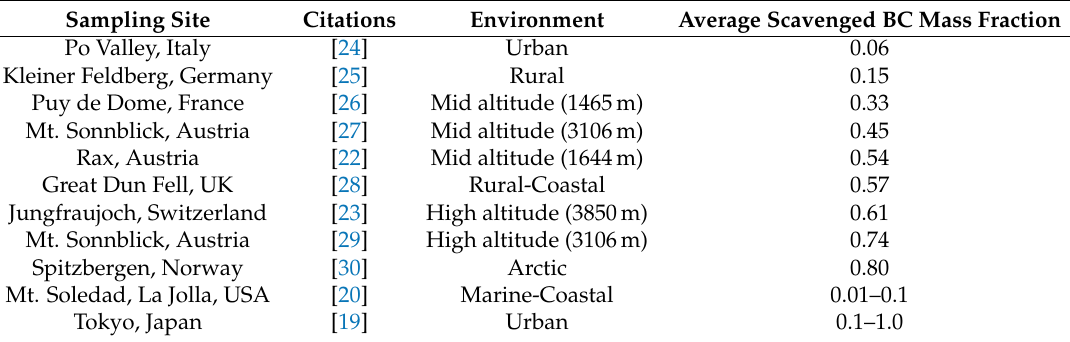
Table 1. Nucleation-scavenged black carbon (BC) mass fraction measurements from previous campaigns. This table is adapted from